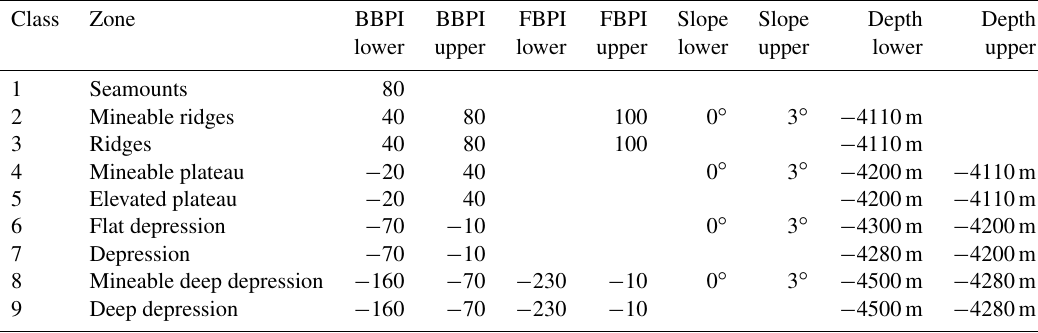
Table A2. Classification dictionary with upper and lower bounds for the classification of the PA1 area used with the BTM. Class